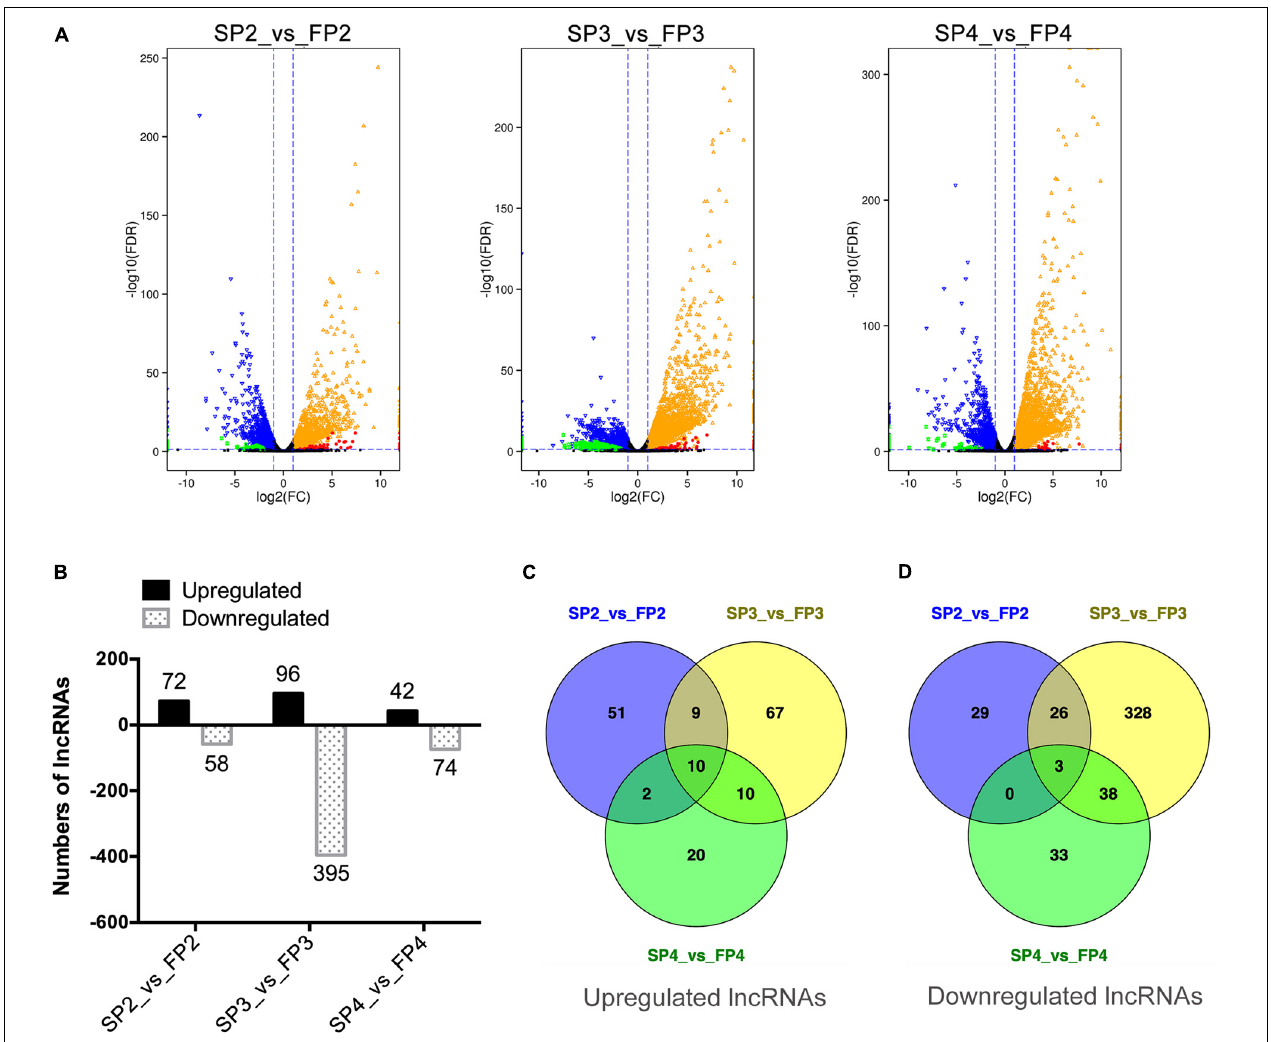
FIGURE 3 | Differential expression of lncRNAs between WXS-S and WXS-F at three pollen developmental stages. (A) Volcano diagrams of differentially expressed genes (DEGs) and DE-lncRNAs in WXS-F compared with WXS-S at three pollen development stages. P-value < 0.05 and |log 2 (fold change)| ≥ 1 indicate that the differences in gene expression are significant. The red and green spots show DE-lncRNAs whose expression was up-regulated or down-regulated, respectively. The orange and blue spots show DEGs whose expression was up-regulated or down-regulated, respectively. The black spots indicate differences in gene expression that are not significant. (B) Number of up- and down-regulated DE-lncRNAs in WXS-F compared with WXS-S at three pollen developmental stages. (C,D) Venn diagrams showing the number of DE-lncRNAs that are commonly up- or down-regulated at three different developmental